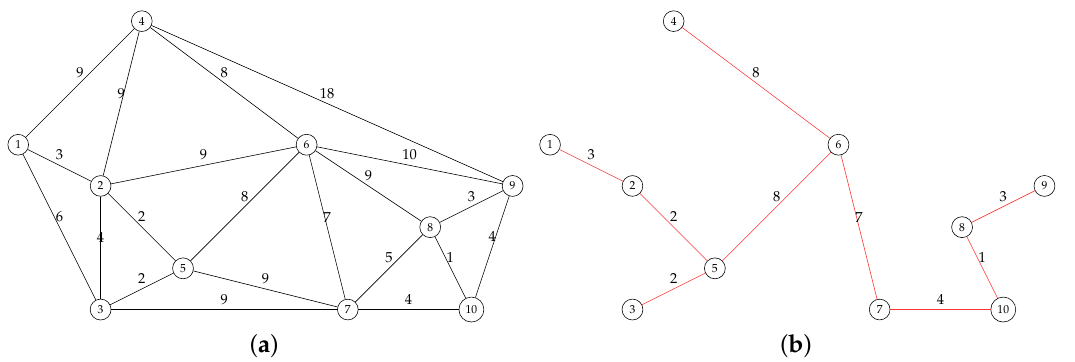
Figure 1. Illustration of weighted graphs. The graph on the right depicts an MST of the graph on the left. ( a ) weighted graph; ( b )